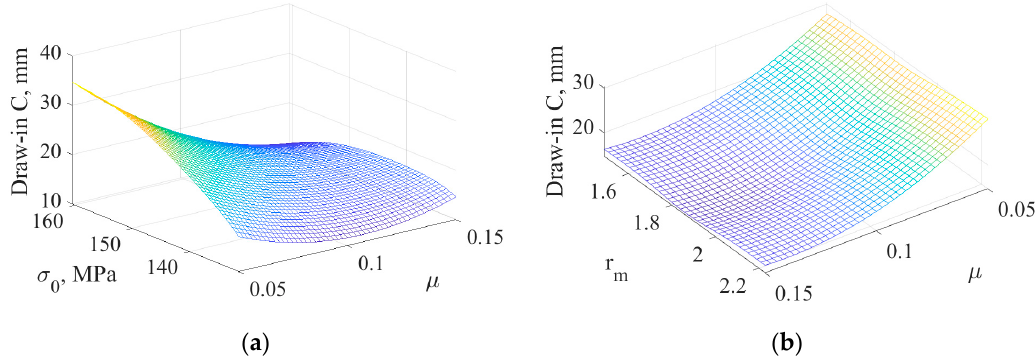
Figure 17. Metamodel of the draw-in at point C for a fluctuation in ( a ) µ and 𝜎 (cid:2868) and ( b ) µ and 𝑟 (cid:3040) .